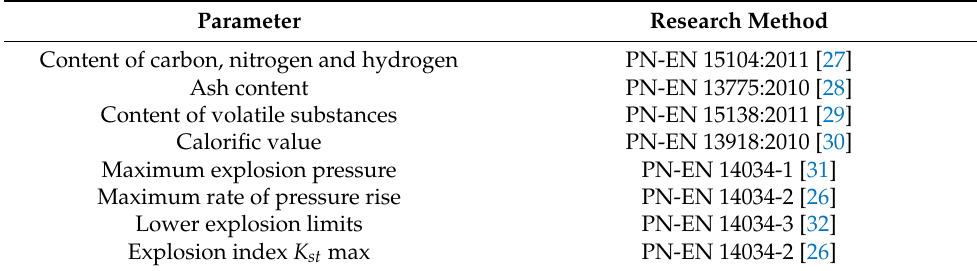
Table 2. Parameters analysed with research